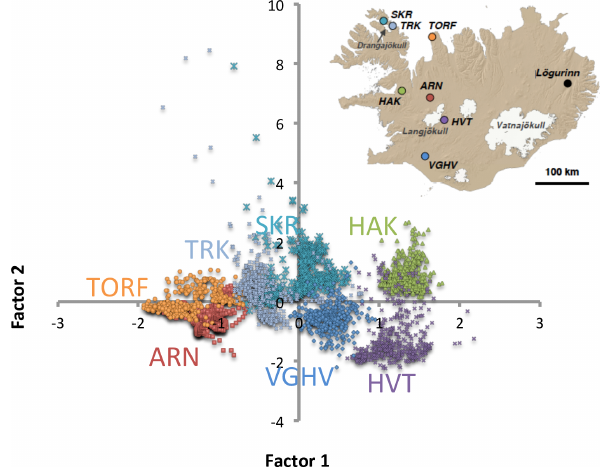
Figure 4. Factor 1 and 2 explain 76.4%. See Table 2 for details.